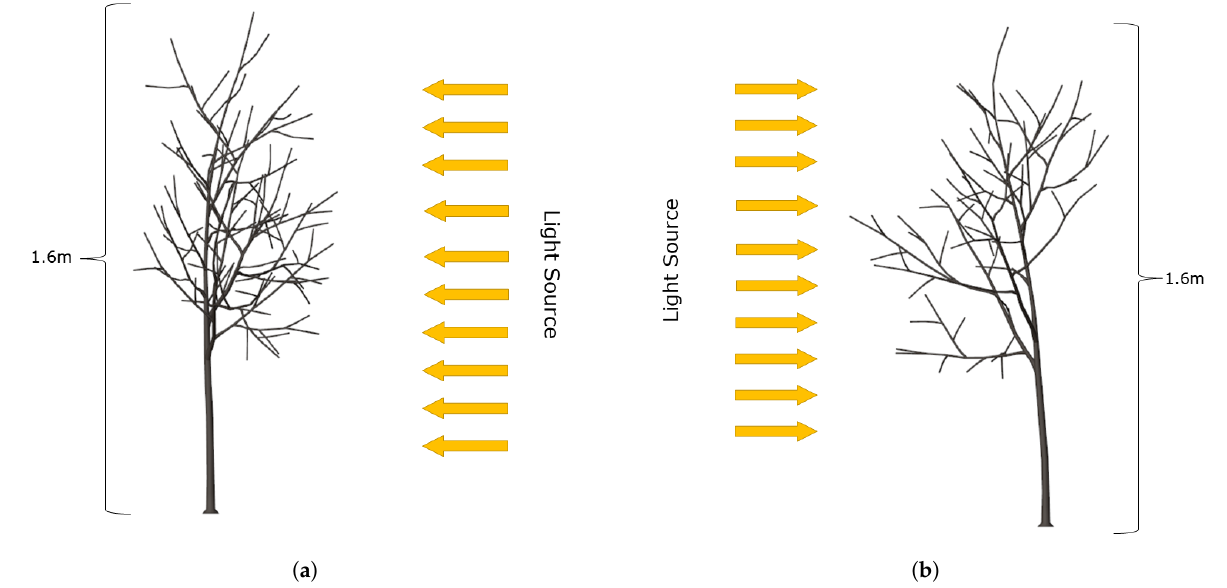
Figure 13. Tree growth with 55° branching angle, 2 children branches and different light source directions. ( a ) Tree growth with light source from right; ( b ) Tree growth with light source from